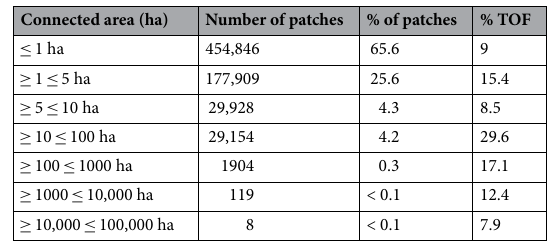
Table 2. The number and size of TOF stands in Bangladesh and the % of stands and % TOF that they account for.